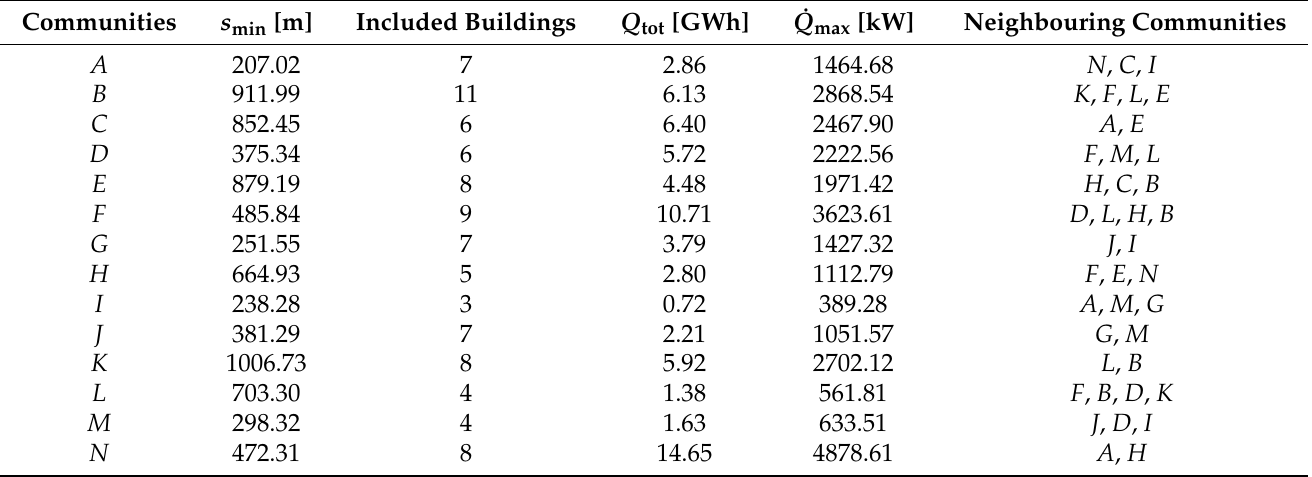
Table 2. Identified communities in the network structure of the FZJ district heating